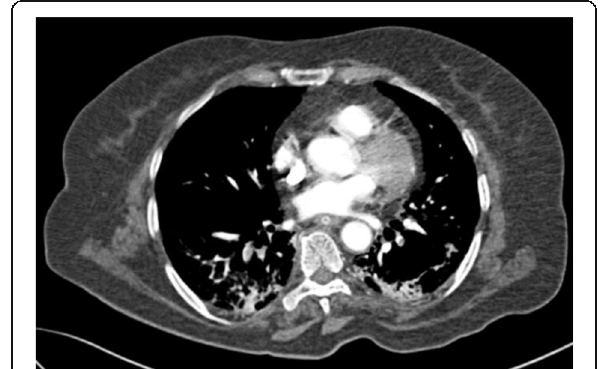
Fig. 5 CT pulmonary angiogram showing bilateral small peripheral pulmonary